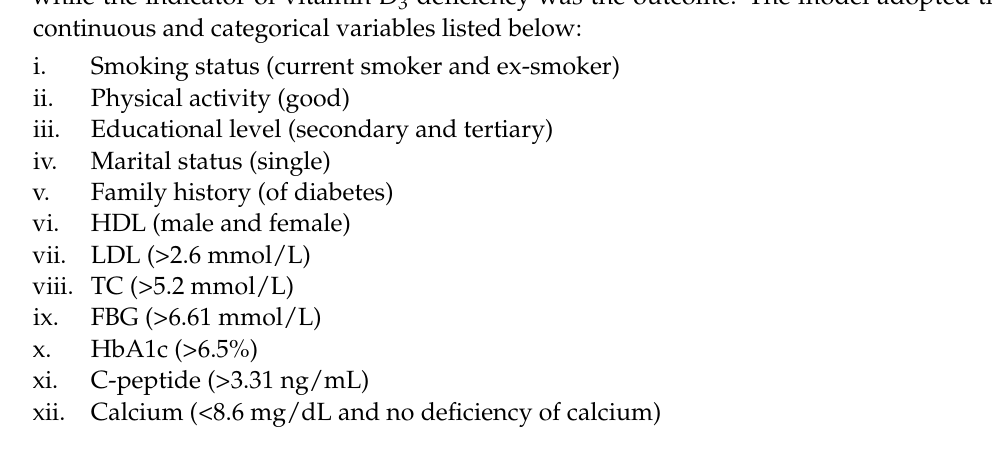
Table 5. Multivariate analysis of vitamin D 3 deficiency.